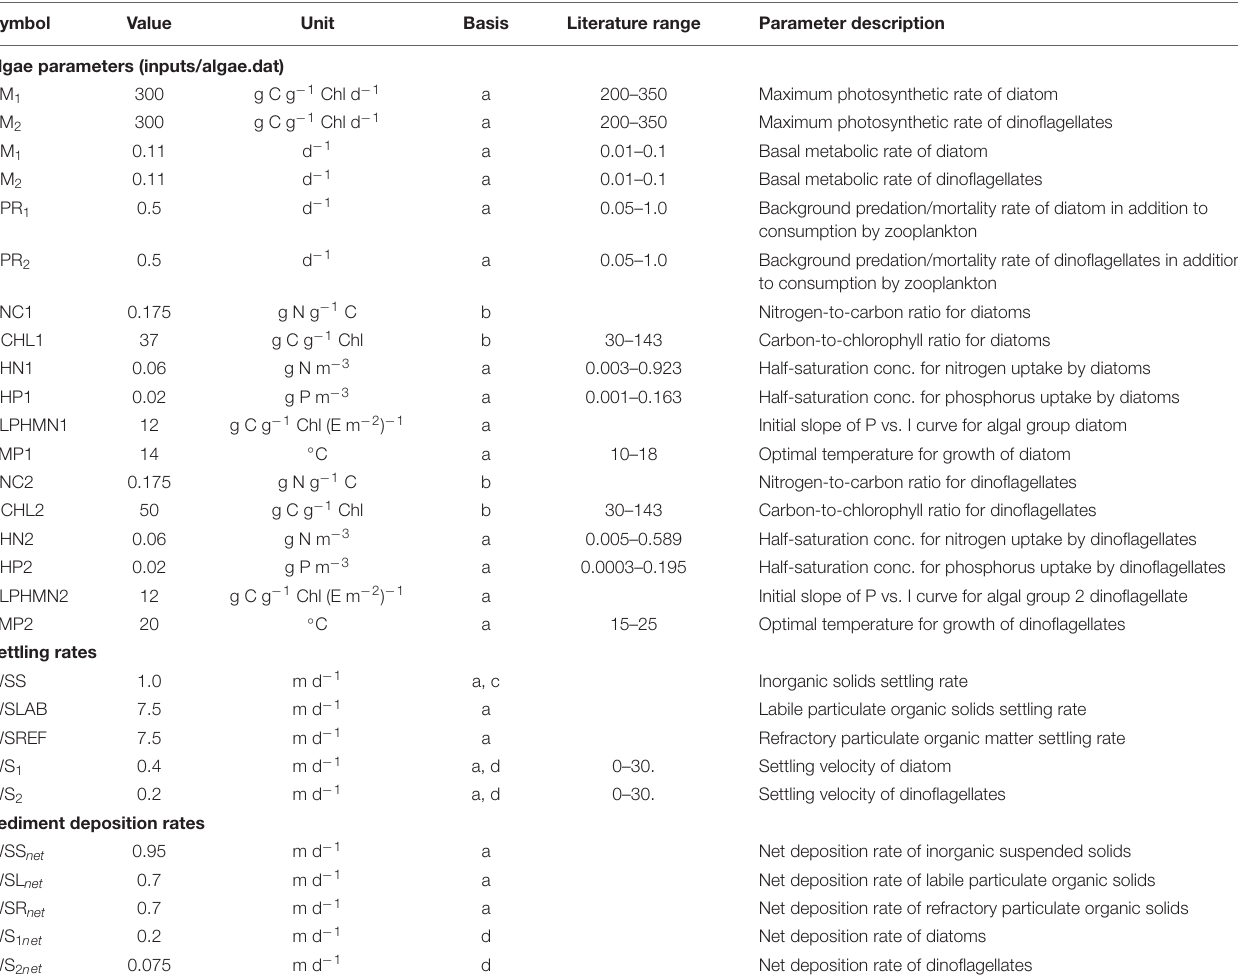
TABLE 1 | A list of major algal kinetics (diatoms and dinoflagellates) model parameters as part of the FVCOM-ICM model implementation for the Salish Sea Model. Symbol Value Unit Basis Literature range Parameter description Algae parameters